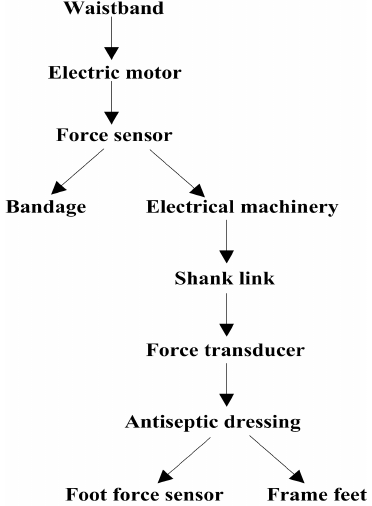
Fig. 3 “Humanoid Robotics” Ontology O 3